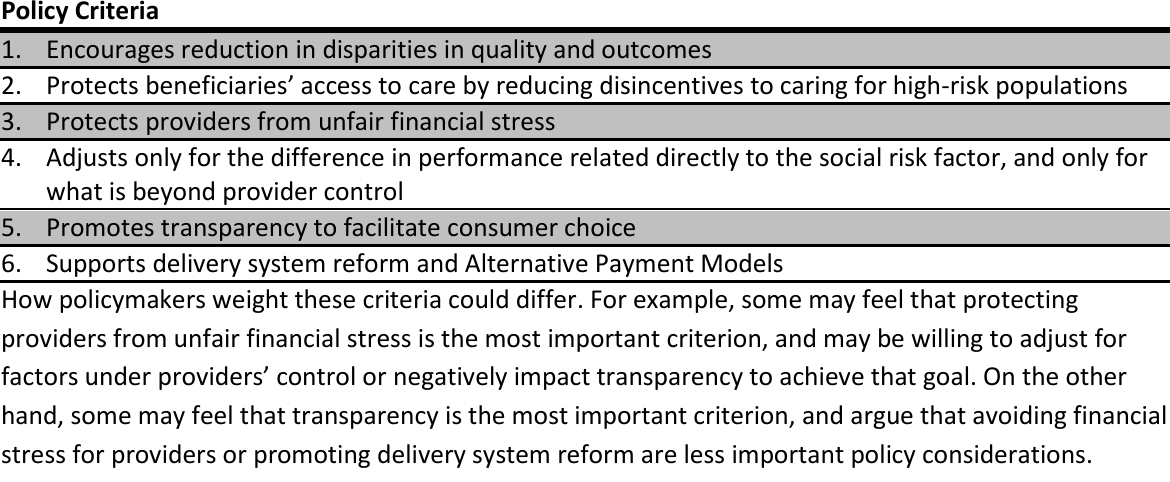
Table 5.6 Policy Criteria Policy